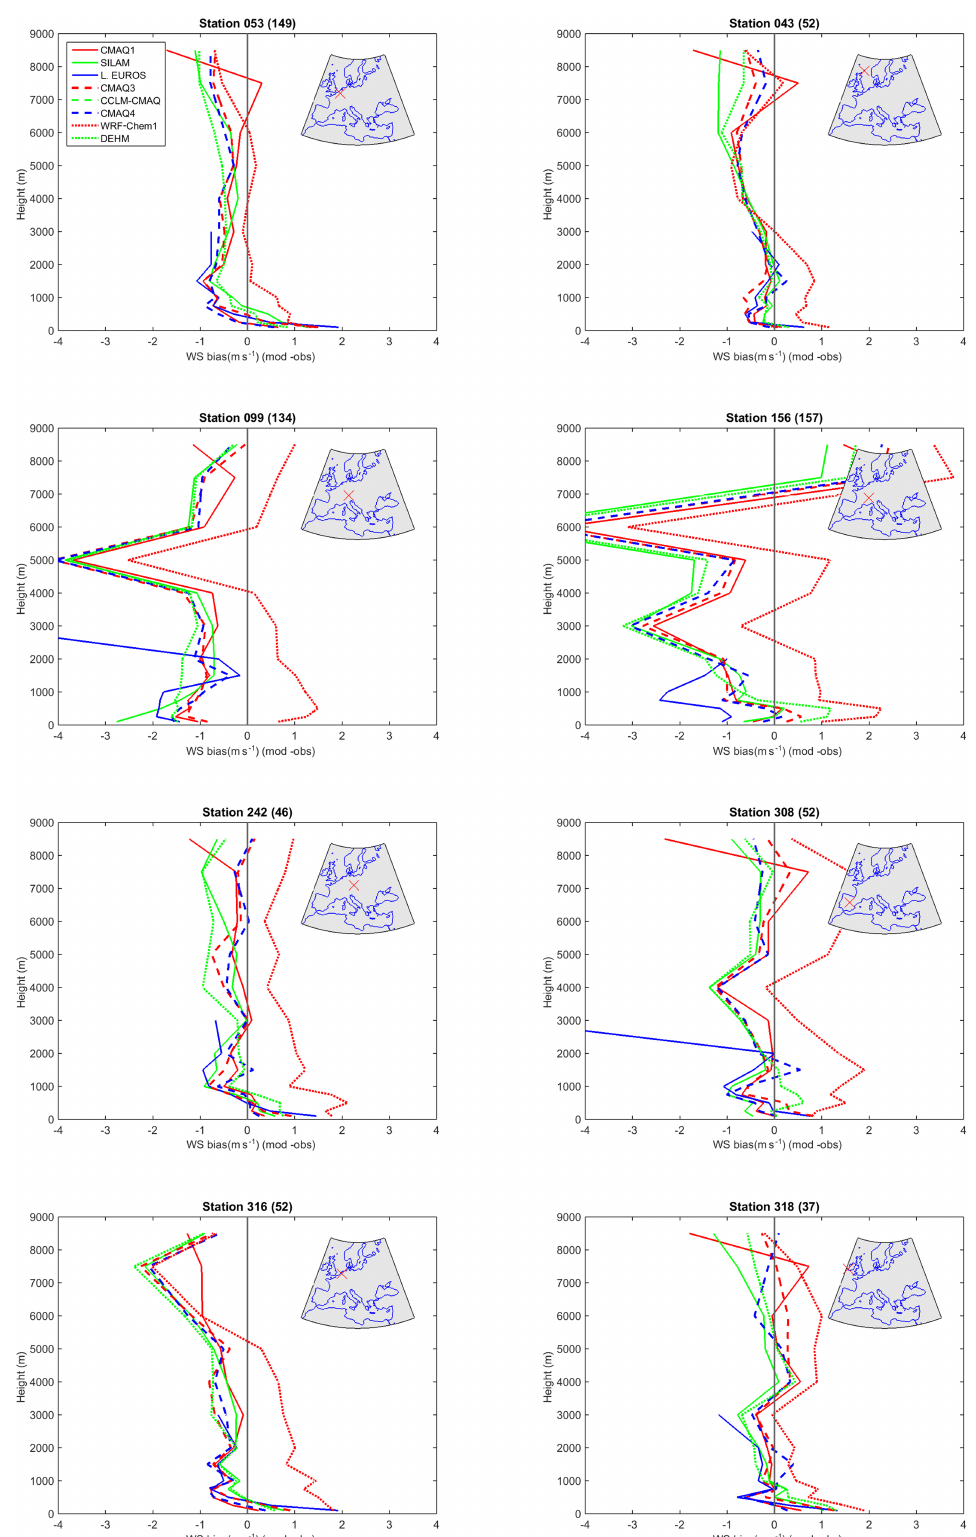
Figure 4. Mean bias (model–observations) for the vertical profiles of wind speed measured by ozonesondes launched from the European locations indicated in the inset map of each panel. The number of hourly profiles available for each site is reported in parentheses at the top of each